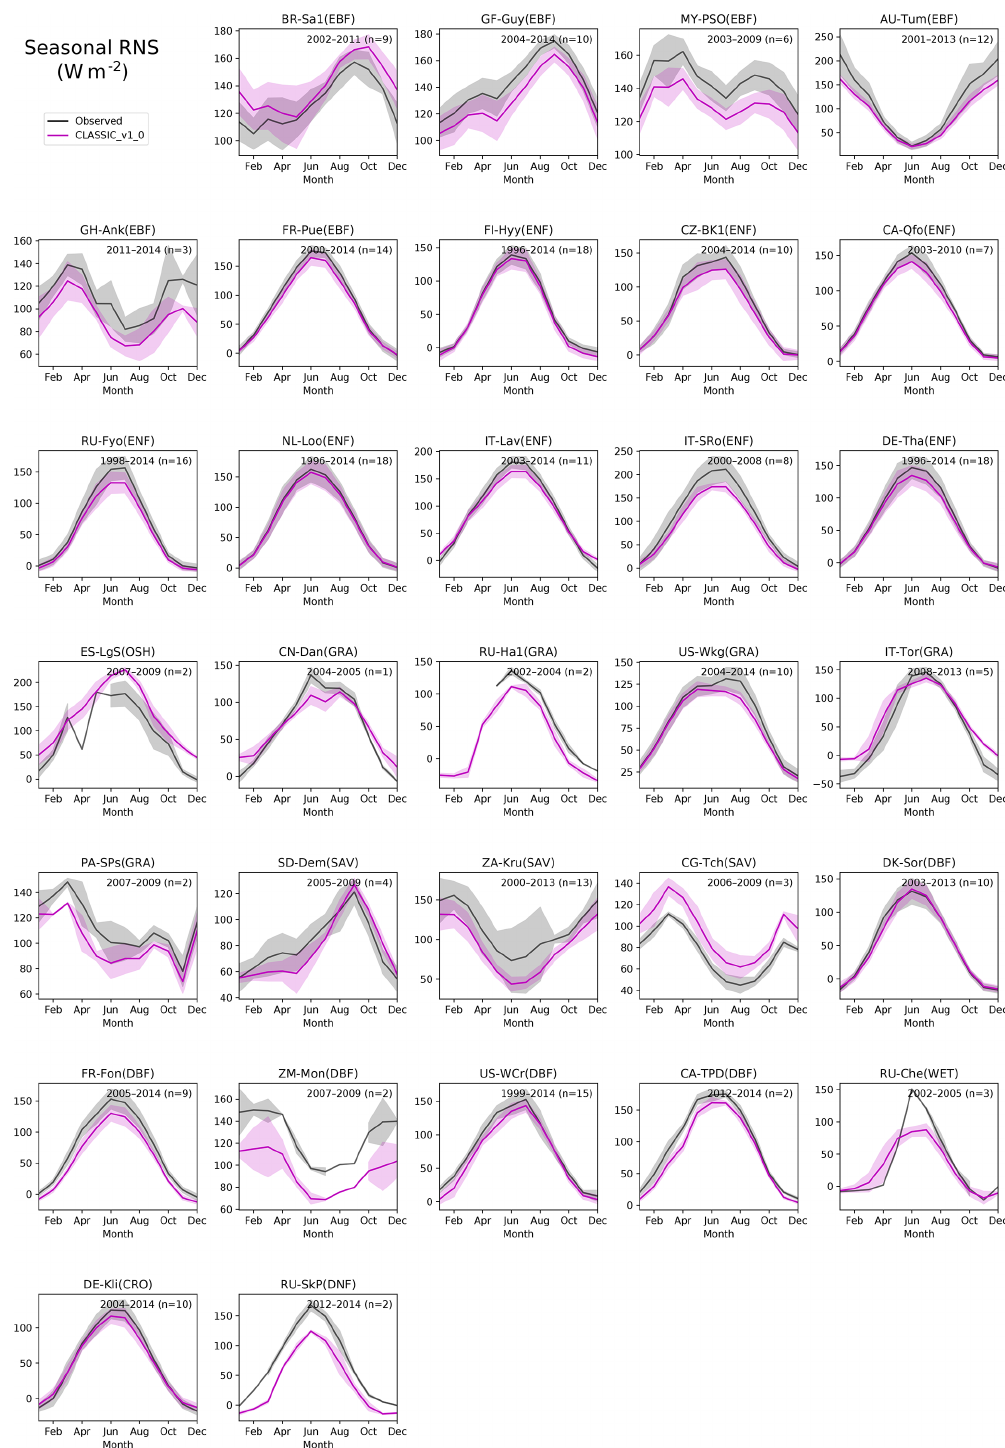
Figure 5. Mean seasonal monthly net radiation for the 31 FLUXNET sites and CLASSIC simulated values. Shaded regions indicate the standard deviation across the sample years. The years of observations for each site are listed along with the site name and IGBP biome which correspond to evergreen broadleaf forest, EBF; evergreen needleleaf forest, ENF; grassland, GRA; deciduous broadleaf forest, DBF; cropland, CRO; open shrubland, OSH; permanent wetland, WET; and deciduous broadleaf forest,